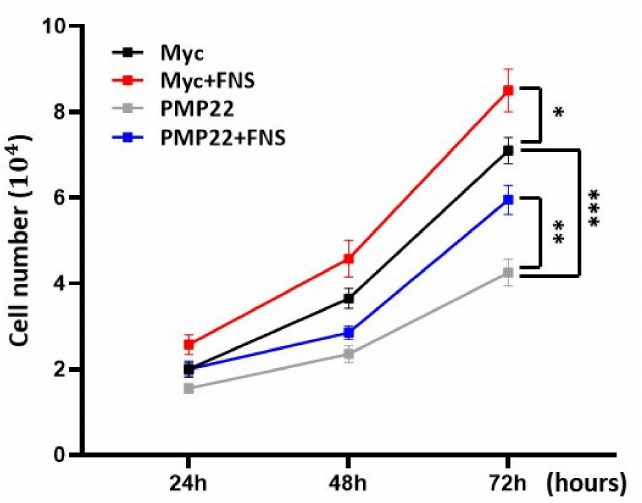
Figure 1. Farnesol increases cell proliferation. RT4 (1 × 10 4 ) cells grown in 12-well plates were transfected with pCMV-myc- PMP22 or pCMV-myc vector with or without 0.1 µ M of farnesol. Direct cell counts after farnesol treatment for indicated times. * p < 0.05; ** p < 0.01; *** p < 0.001. Next, we addressed whether farnesol promotes myelination of Schwann cells. As demyelination by PMP22 overexpression is a prominent pathophysiology in CMT1A patients, we investigated whether farnesol restores the myelination process in PMP22 - overexpressing cells. After transfecting pCMV-myc- PMP22 into RT4 cells, farnesol was treated for 48 h, and changes in mRNA levels were analyzed. We used Oct6, a transcription factor for myelination, and MPZ, a myelin protein, to determine changes in myelination. The overexpression of PMP22 reduced the mRNA expression level of MPZ and Oct6 by 92% ( p < 0.001) and 82% ( p < 0.01), respectively. In this setting, treatment with farnesol (0.01 µ M and 0.1 µ M) restored the expression levels of those genes to the levels in the control vector-transfected cells. In addition, farnesol treatment also increased mRNA levels of Oct6 and MPZ in the control cells (Figure 2). These results imply that farnesol promotes the expression of several myelination-related genes in PMP22 -overexpressing Schwann